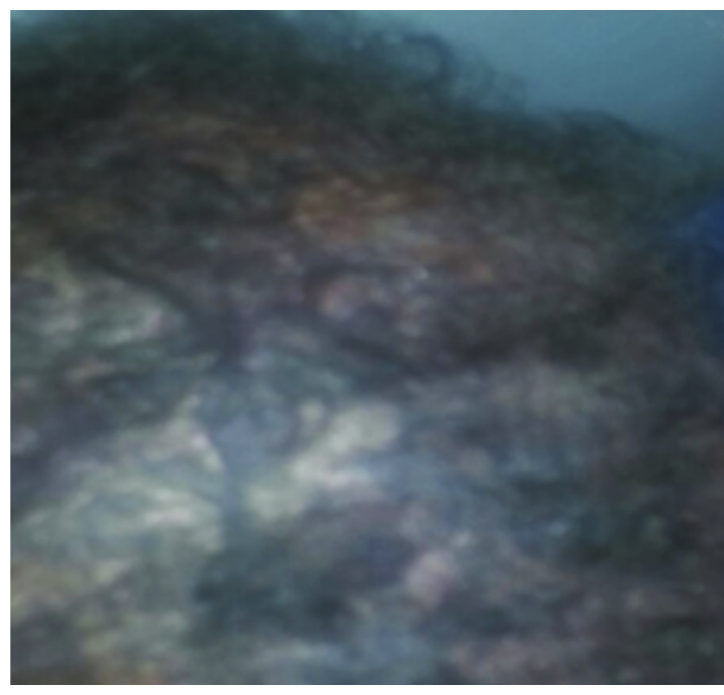
Figure 4: Scaly scalp.